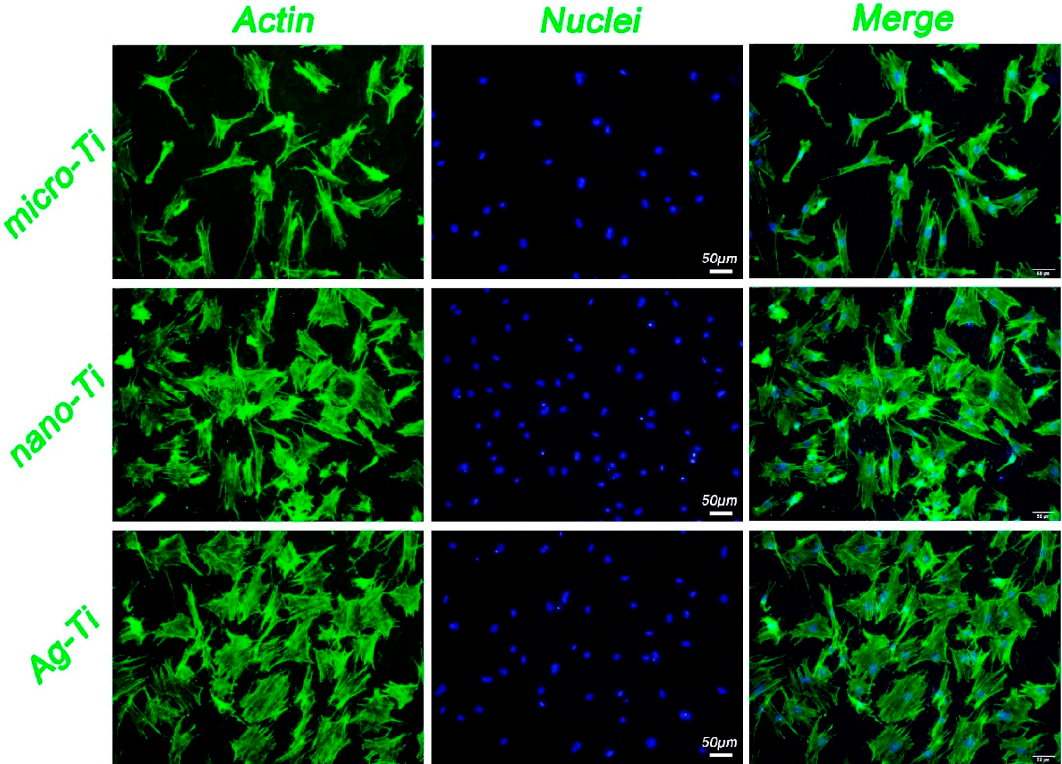
Figure 9. Investigation of the initial adhesion and spreading behaviors of mesenchymal stem cells (MSCs) after 24 h of culture on the samples micro-Ti, nano-Ti and Ag-Ti. Note: actin, green; nuclei, blue [62]. Reprinted with permission from reference [62] 2016 Elsevier.